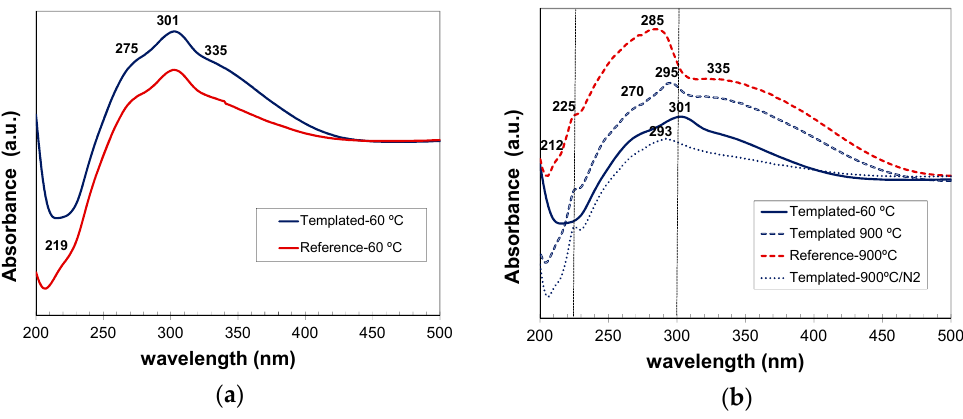
Figure 14. Absorbance spectra of: ( a ) reference and C12GA-templated as-prepared CePO 4 samples (60 °C-dried); and ( b ) reference and templated CePO 4 materials after annealing at 900 °C (under air or N 2 conditions), showing also the spectrum of 60 °C-dried templated sample for comparison purposes.